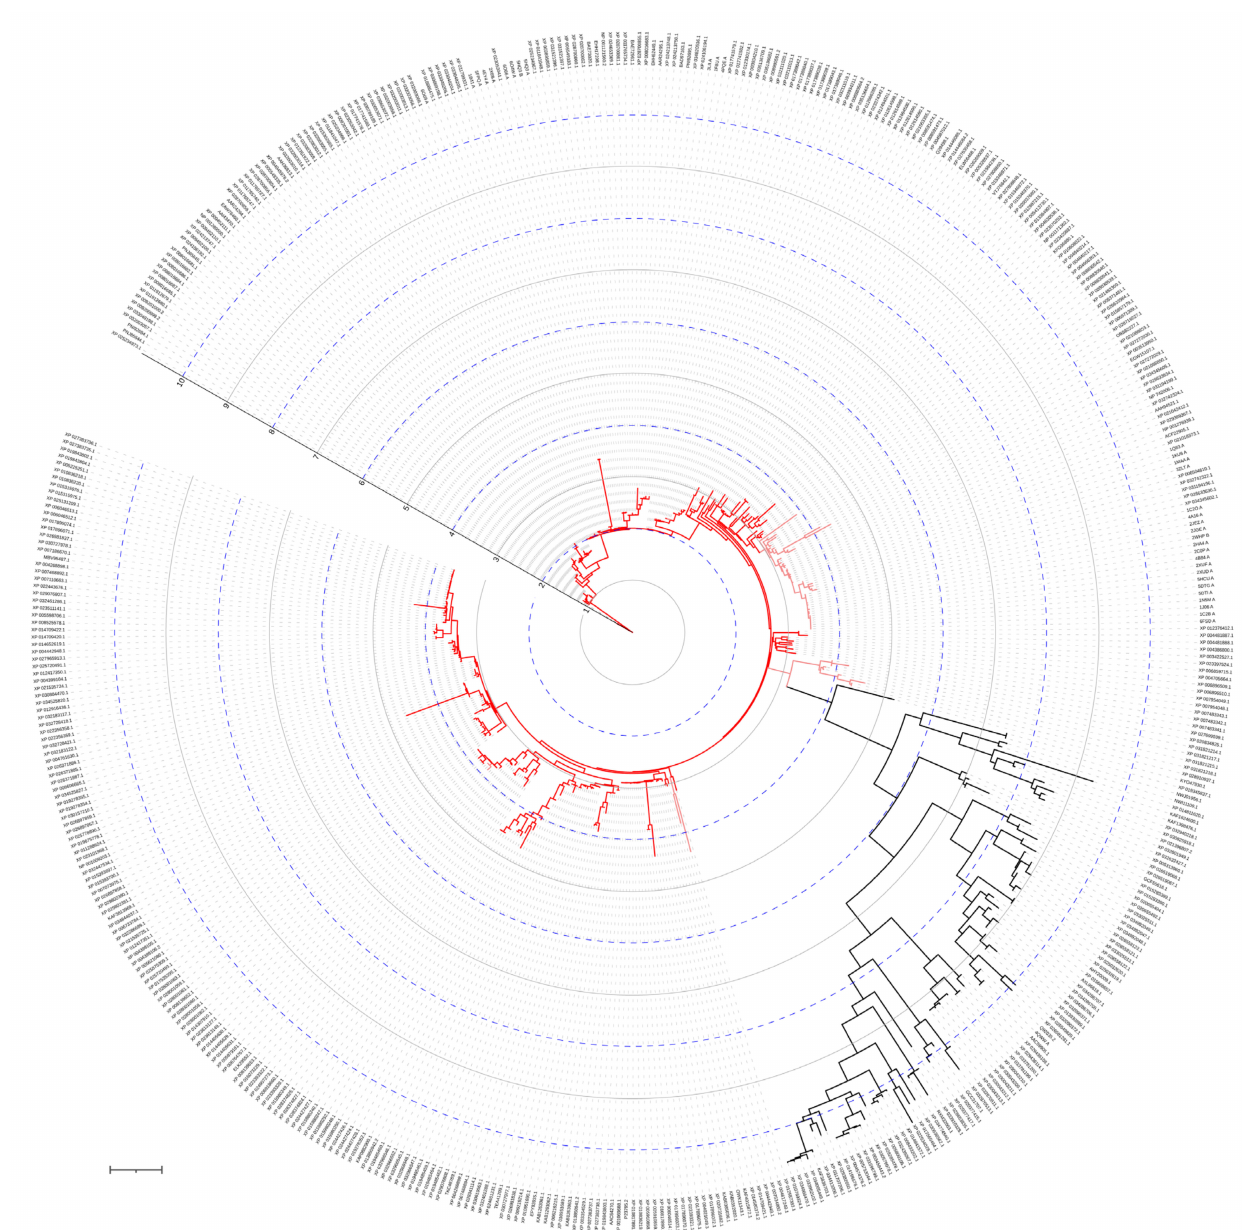
Figure 17. Phylogenetic tree of human AChE and its homologous enzymes (down to 58% identity). The tree was built as previously with PDB 2XMG as a reference sequence. Enzymes having high (90–100%) and good (80–89%) identity are highlighted with red and pink,